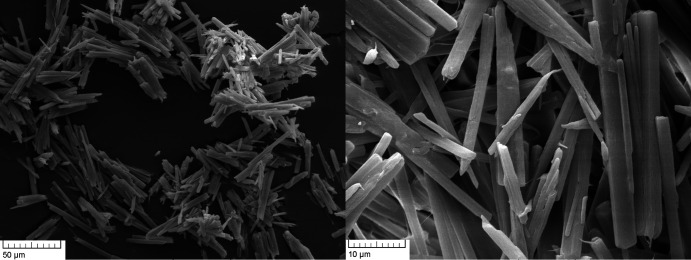
SEM images of MgCO3·MgCl2·7H2O, with the crystals exhibiting twinning or even further inter­growth.